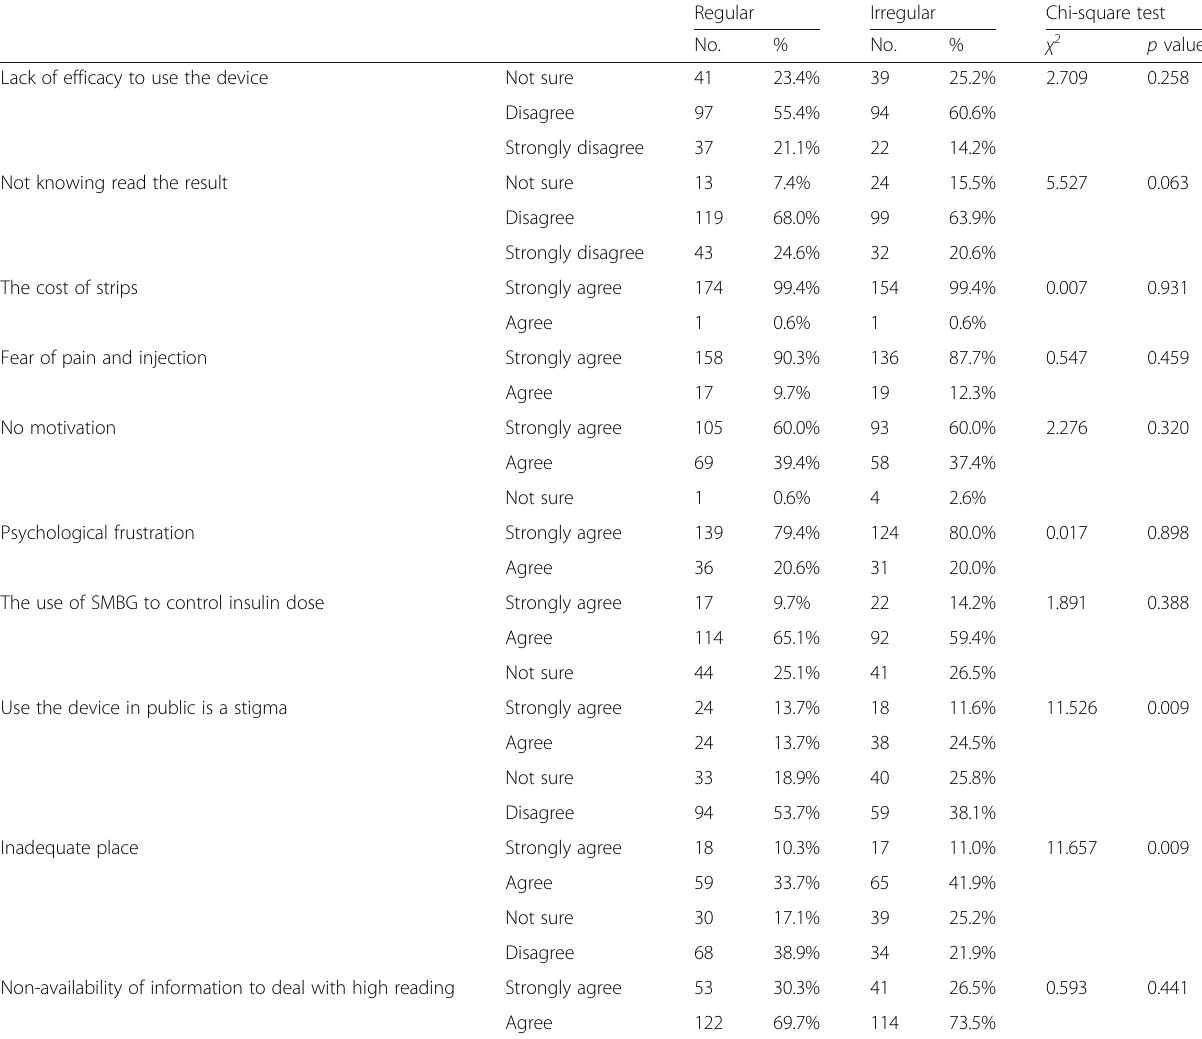
Table 4 Comparison between patients on regular and those on irregular SMBG regarding the opinion of the children and their parents about the most influential factors affecting compliance of SMBG Regular Irregular Chi-square test